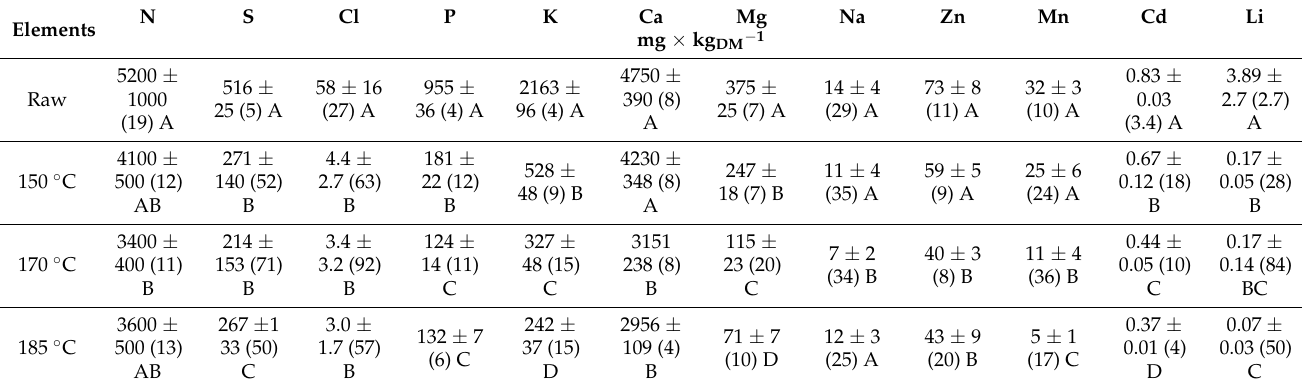
Table 2. Elements and trace elements detected in the raw material and the thermally treated material (mean ± standard deviation (coefficient of variation [%])). Different letters indicate significant differences of p < 0.05 between the datasets. Elements